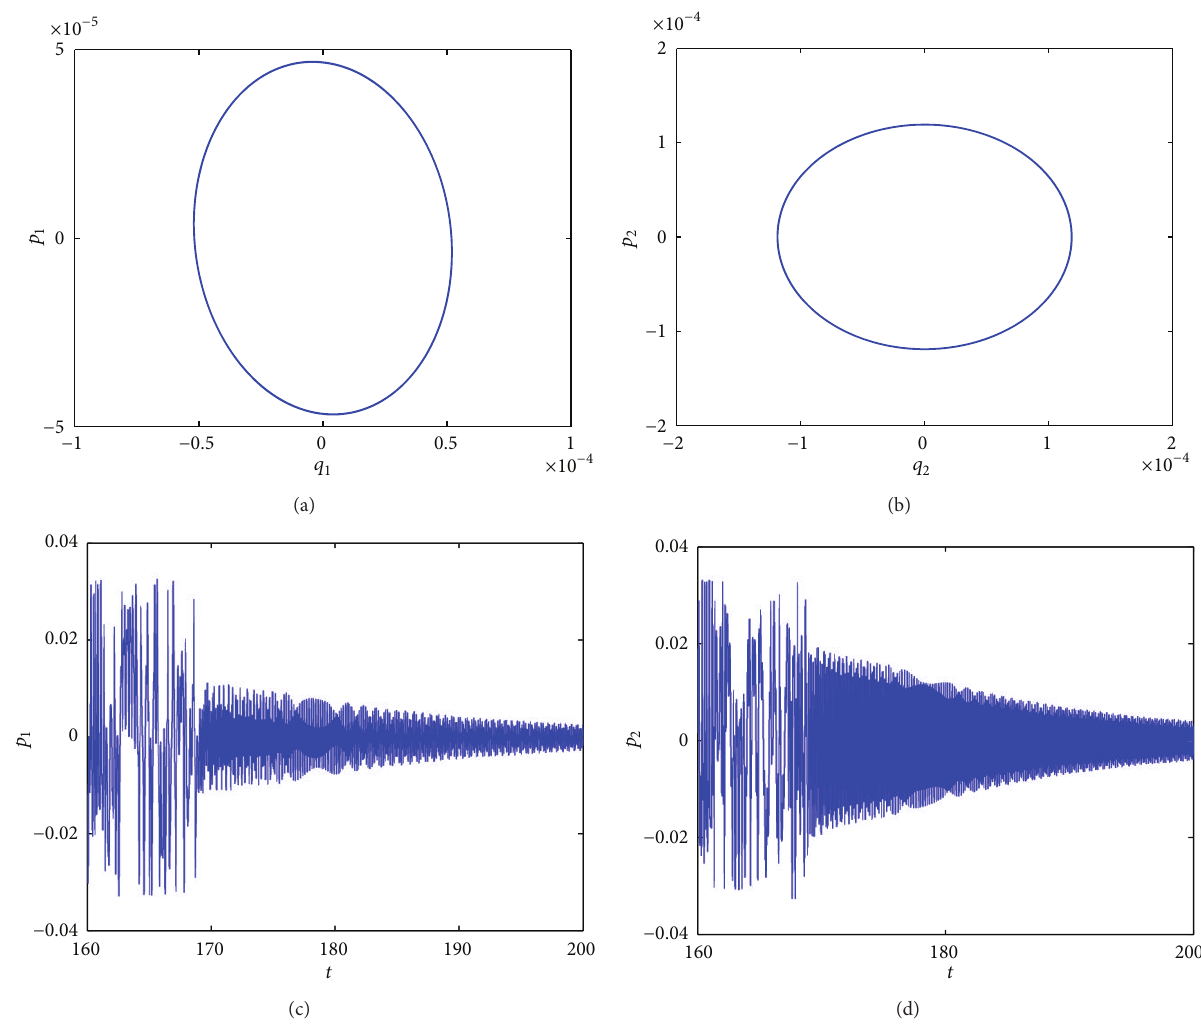
Figure 13: Phase portraits (a, b) and time histories (c, d) for 𝜎 2 = 115.7201 , 𝜇 = 0.05 , V 1 = 10 , 𝛼 = 0 , and 𝜎 1 = 92.39